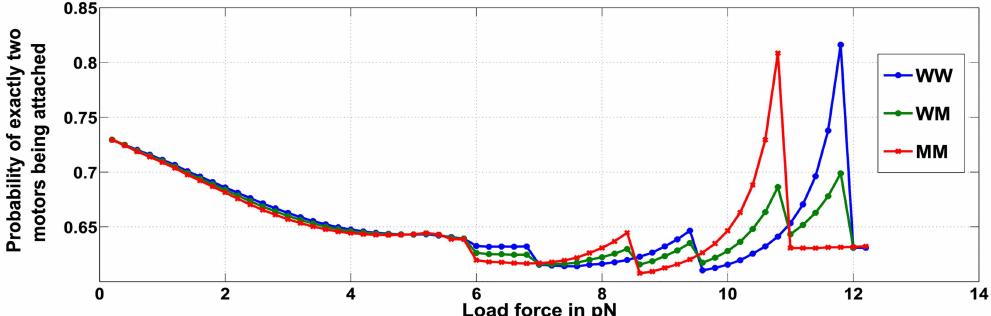
Fig 2. Probability of exactly two motors attached to the microtubule for ensembles WW, WM and